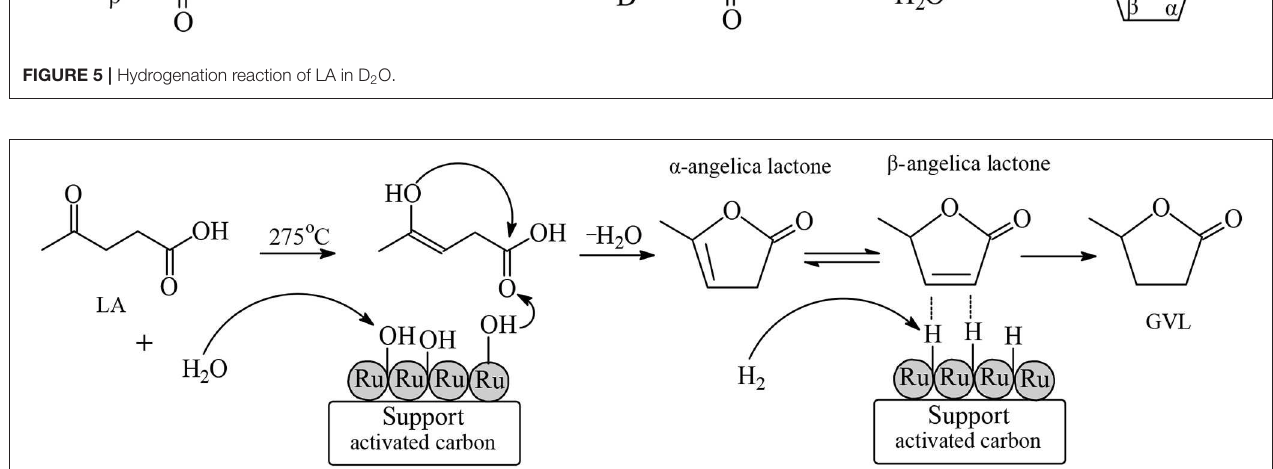
FIGURE 6 | Proposed mechanism for the hydrogenation of LA to GVL at 275 ◦ C on the surface of Ru/C catalyst in aqueous